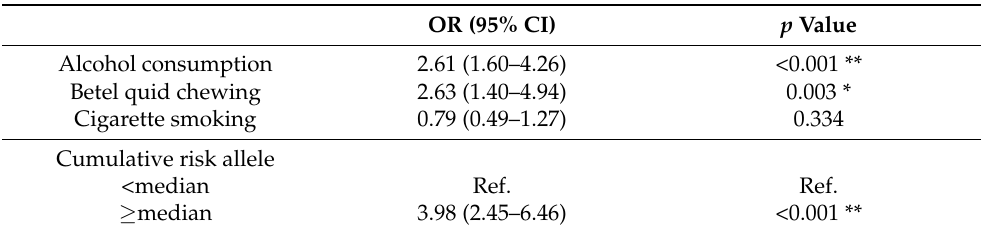
Table 3. Cumulative risk effect of 13 SNPs on nasopharyngeal carcinoma susceptibility in multivariate logistic regression model.